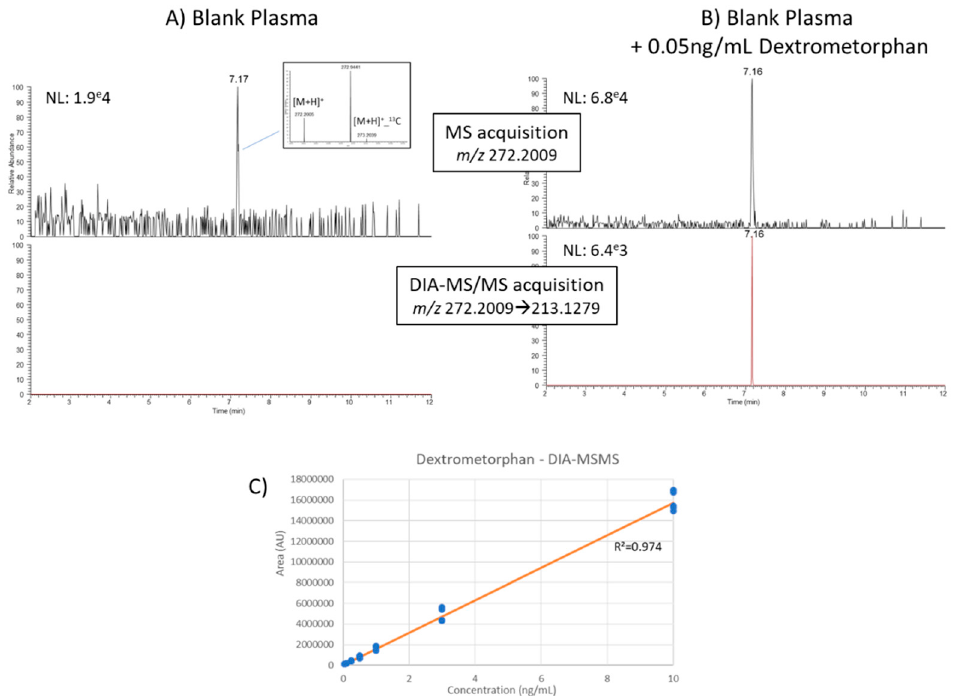
Figure 7. Example of Dextrometorphan. ( A ) A metabolite feature probably misidentified in blank plasma as dextromethorphan by the full-scan MS method and not confirmed by the DIA-MS / MS approach, ( B ) similar data as in ( A ) but after spiking 0.05 ng / mL of pure dextromethorphan in plasma. ( C ) calibration curve of dextromethorphan in human plasma as analyzed by DIA-MS /